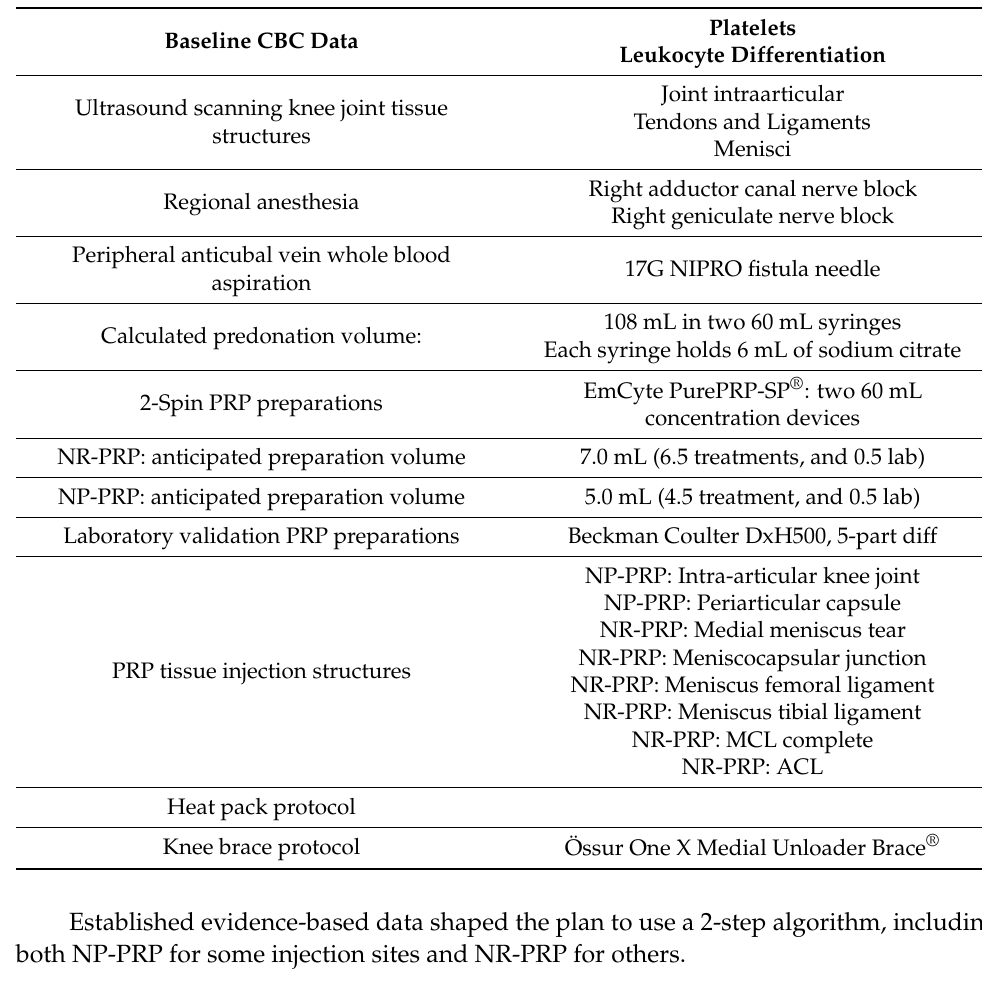
Table 2. Blueprint of the Personalized PRP Treatment Plan Right